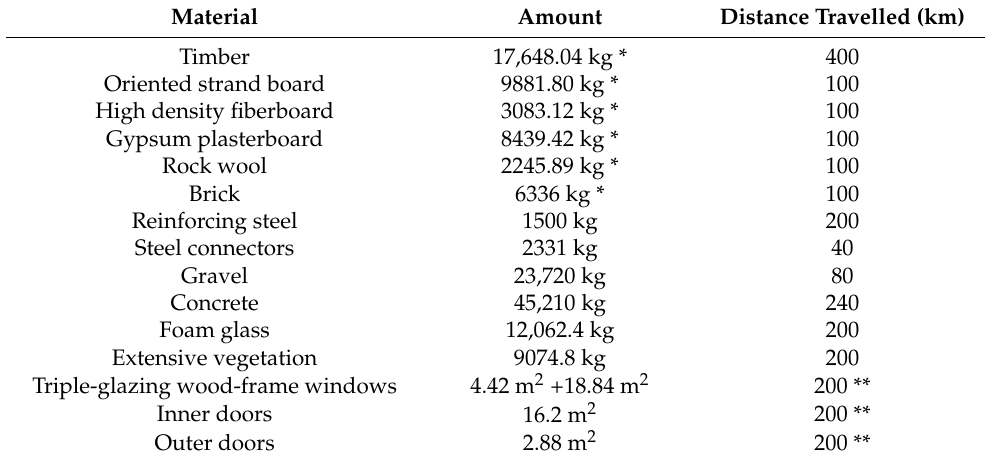
Table 1. List of materials included in the assessment. Columns Amount and Distance travelled (km) refer to stages A1–A3 and A4, respectively.